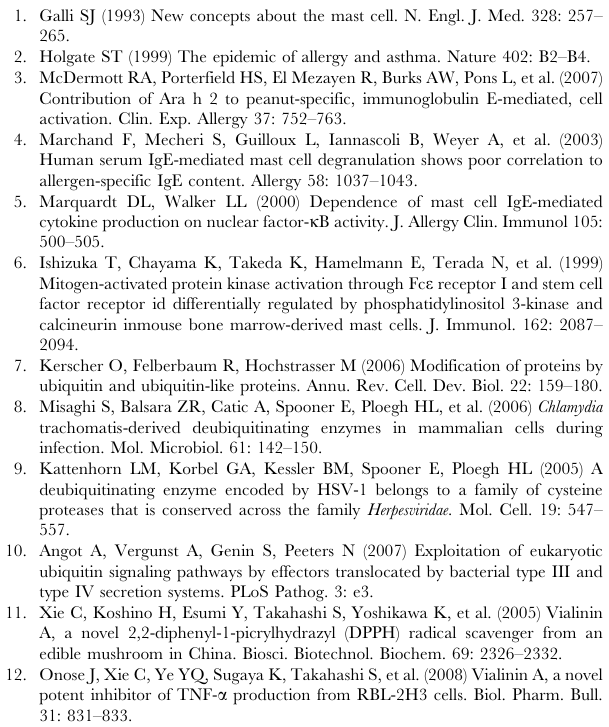
Figure S2 Effect on IL-4 release from DUB siRNA- knockdown cells. Amount of IL-4 release from RBL-2H3 cells treated by DUB siRNA were determined by ELISA. Figure S3 Cell viability for DUB siRNA-knockdown cells. Effect on lactate dehydrogenase leakage from RBL-2H3 cells treated by DUB siRNA. Amount of lactate dehydrogenase were determined by measuring absorbance 490 nm. Table S1 siRNA sequences. Table S2 Primers used for real-time PCR. Table S3 Conditions used for real-time